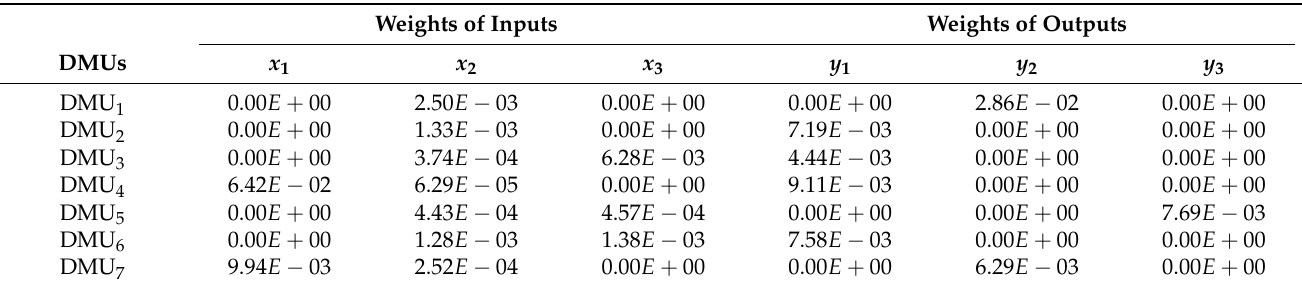
Table 3. Weights obtained from the EPCE model.